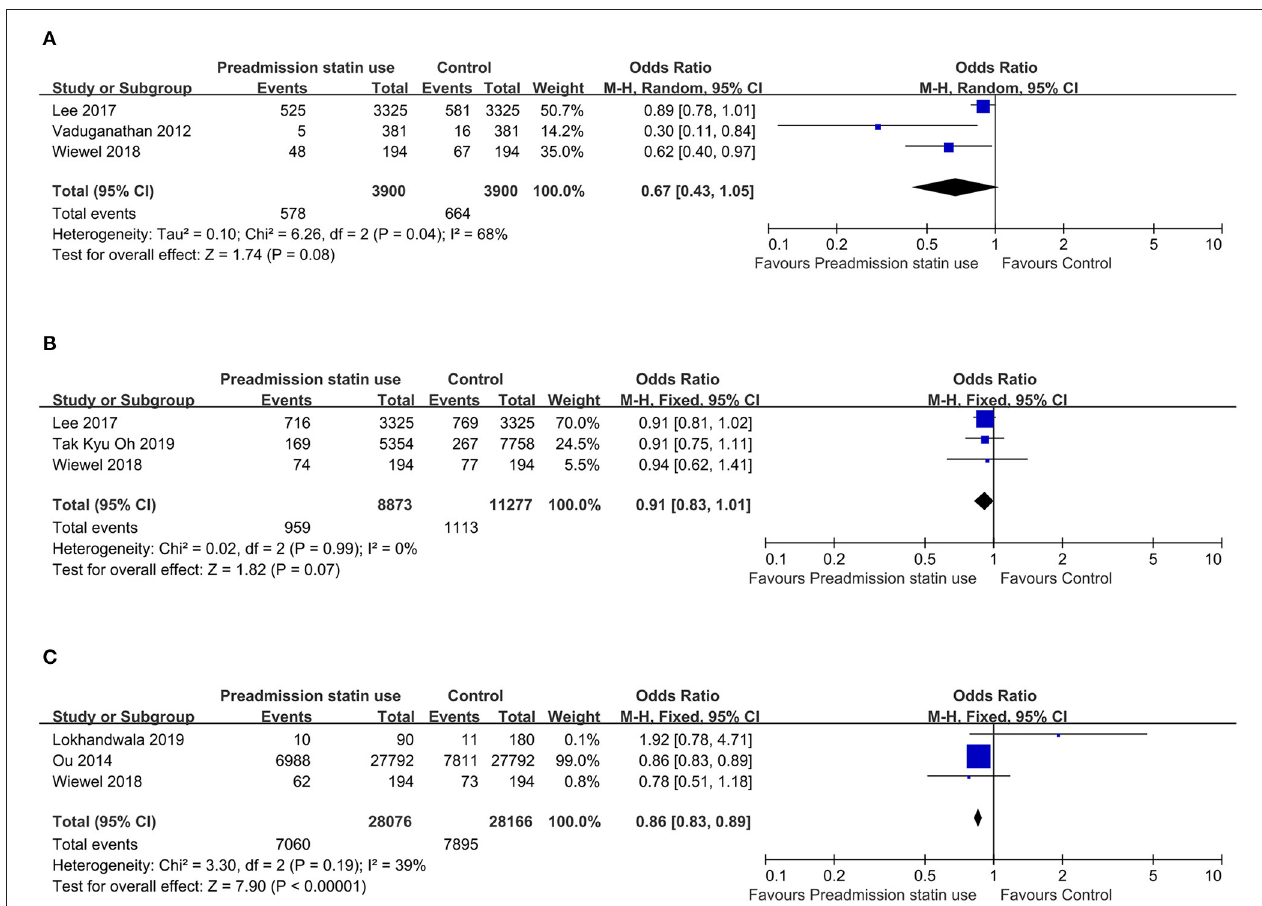
FIGURE 3 | (A) Forest plot of 30-day mortality comparing preadmission statin use to no use in critically ill patients. (B) Forest plot of 90-day mortality comparing preadmission statin use to no use in critically ill patients. (C) Forest plot of hospital mortality comparing preadmission statin use to no use in critically ill patients. CI, confidence